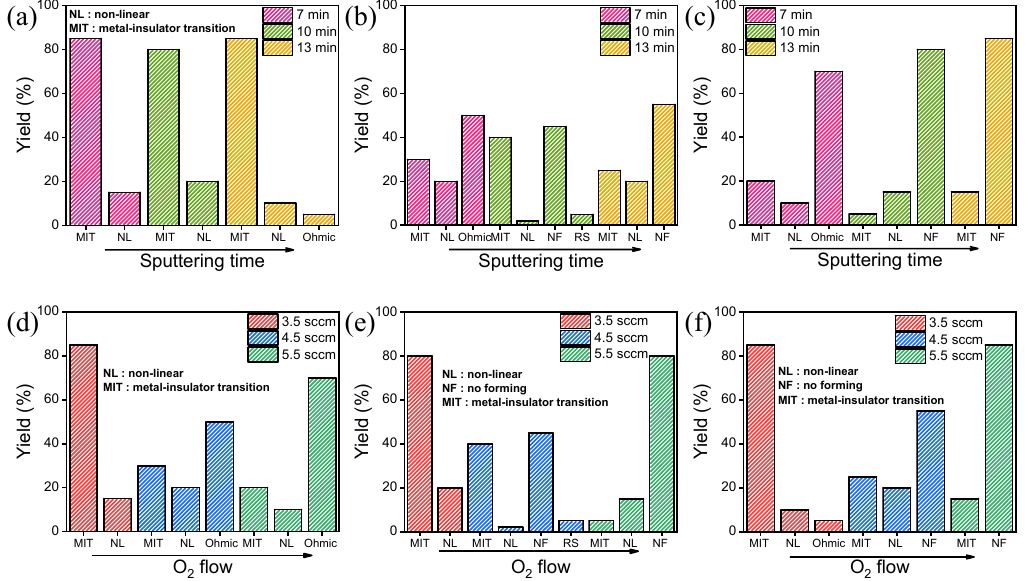
Figure 2. MIT characteristic yield of TiN/NbOx/TiN devices with different oxygen flow rates: ( a ) 3.5 sccm, ( b ) 4.5 sccm, and ( c ) 5.5 sccm. MIT characteristic yield of TiN/NbOx/TiN devices with different sputtering times: ( d ) 7 min, ( e ) 10 min, and ( f ) 13